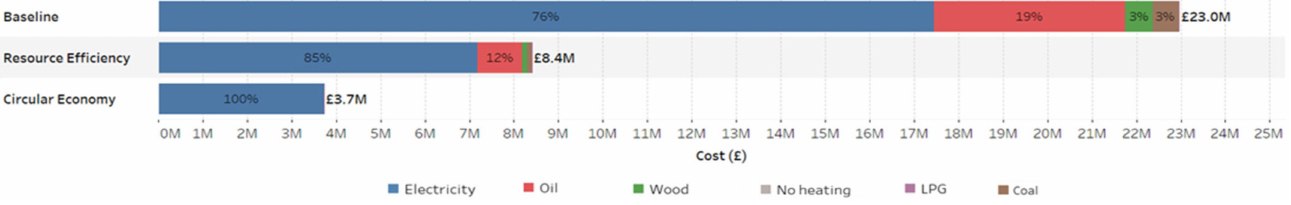
Figure 13. Heating energy cost of baseline model by archetypes and specifications and future